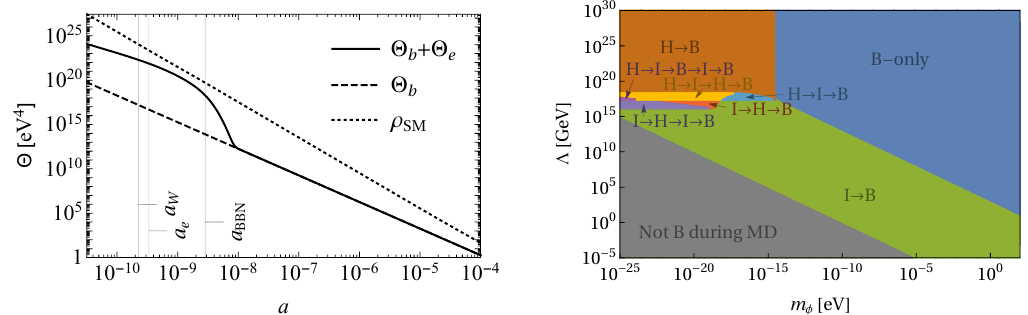
Figure 1 : Left: the evolution of Θ as a function of scale factor (solid line). The contri- SM bution of non-relativistic baryons Θ ∝ a − 3 is displayed by the dashed line for reference. b Notice the large contribution from the e + e − plasma. For reference, we also show the to- tal energy density ρ (dotted line). Vertical lines mark the values of the scale factor SM corresponding to freeze-out of weak interactions ( a ), the time when electrons become W non-relativistic ( a ) and BBN ( a ). Right: map of the transition history of DM evo- e BBN lution for various points in parameter space. Each region is labeled with the regimes the field φ passes from the weak freeze-out to the present time. Example: I → H → B refers to an evolution that starts out dominated by the induced mass, then transitions to being dominated by Hubble friction and finally by the bare mass, m . The gray-shaded region φ on the bottom left is excluded by the condition eq.